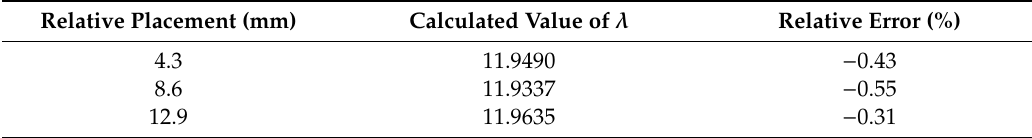
Table 3. Impact of the relative